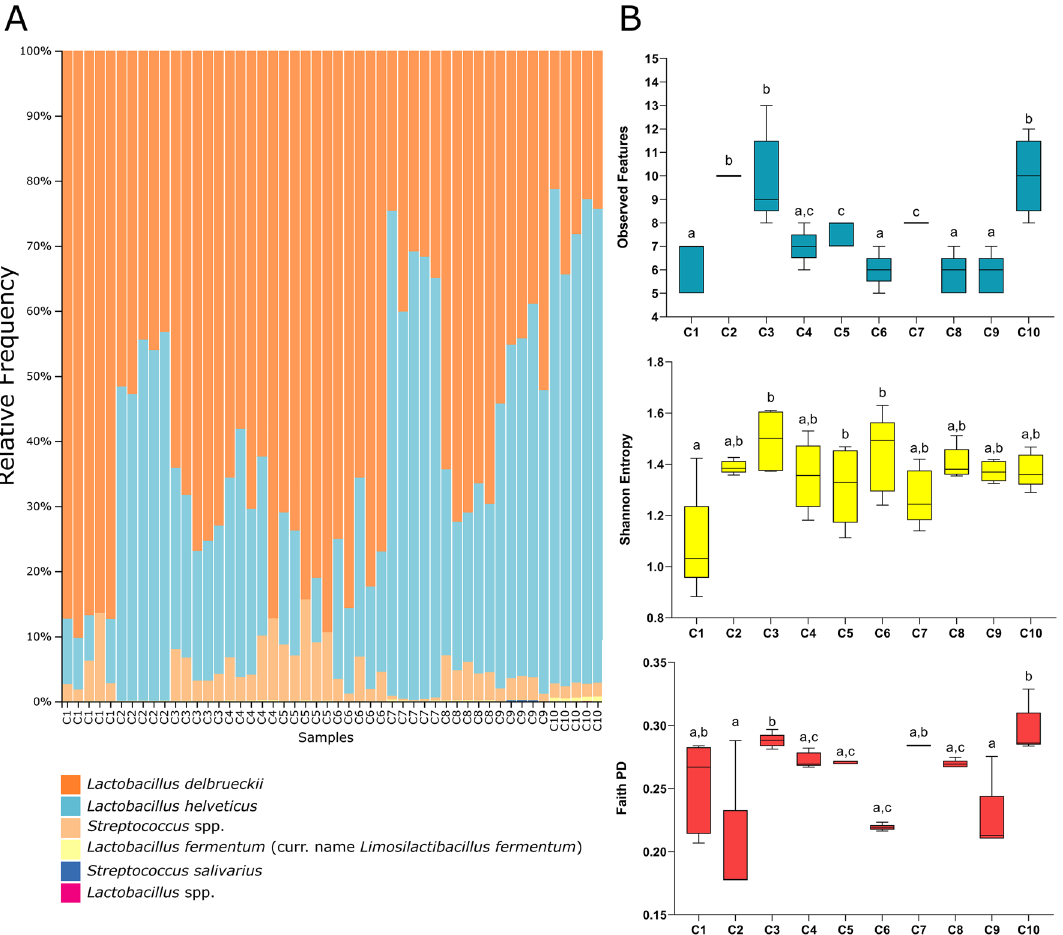
Figure 3. Relative abundance and alpha diversity analysis of NWS samples. ( A ) Cumulative bar chart representing the relative abundance on the vertical axis and the NWS samples (treatments; n = 50) on horizontal axis. Only taxa contributing to more than 0.1% of the total abundance in at least one sample are shown. ( B ) Observed features, Shannon index, and Faith’s PD index. Plotted with GraphPad Prism v.8.00 software (San Diego, CA, USA, https:// www. graph pad.